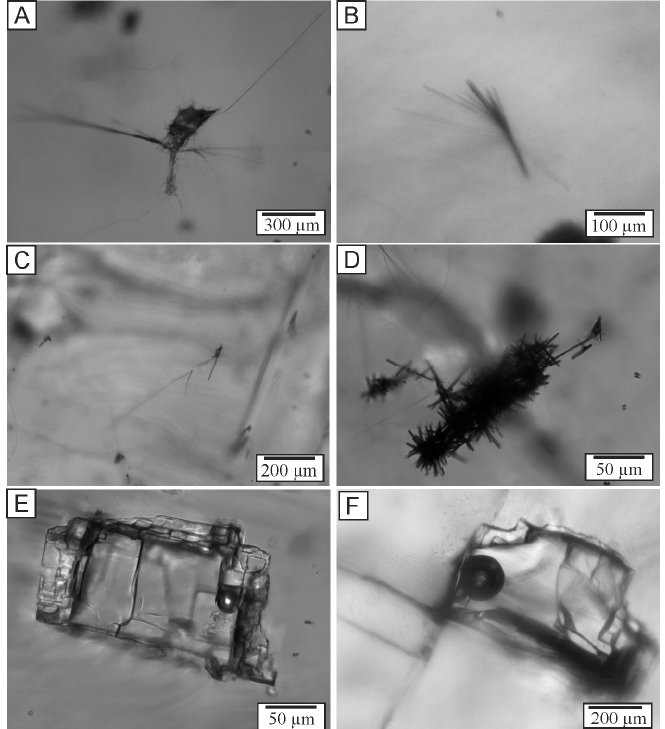
Figure 7. Microscopic images (1N) of: ( A ) concentration of very thin and long, bent and tangled needles of manganite within halite crystal (depth − 1190.4 m a.s.l.). ( B ) Set of manganite needles growing from one point (depth − 1187.6 m a.s.l.). ( C ) Single or in pairs manganite needles in clean halite crystal (depth − 1187.6 m a.s.l.). ( D ) Manganite prismatic crystals in inclusion (depth − 1187.6 m a.s.l.). ( E ) Large LG inclusion with rough walls (depth − 1195.8 m a.s.l.). ( F ) Large LG inclusion with larger vapor bubble and tracks of small fluid inclusions (depth − 1190.7 m